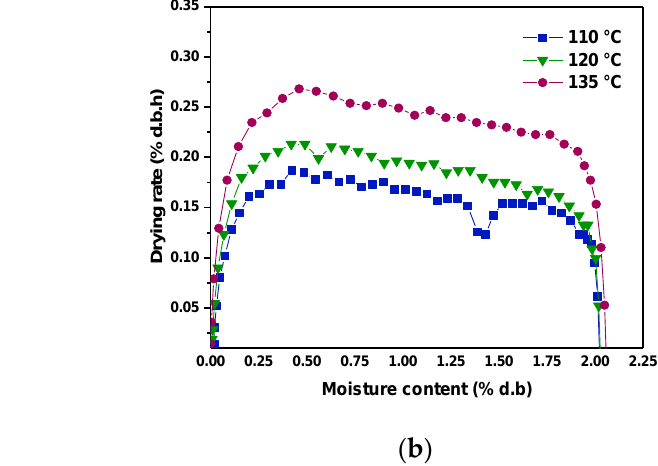
Figure 4. Variation of the drying rate versus the moisture content, ( a ): 1 cm and ( b ): 2 cm.